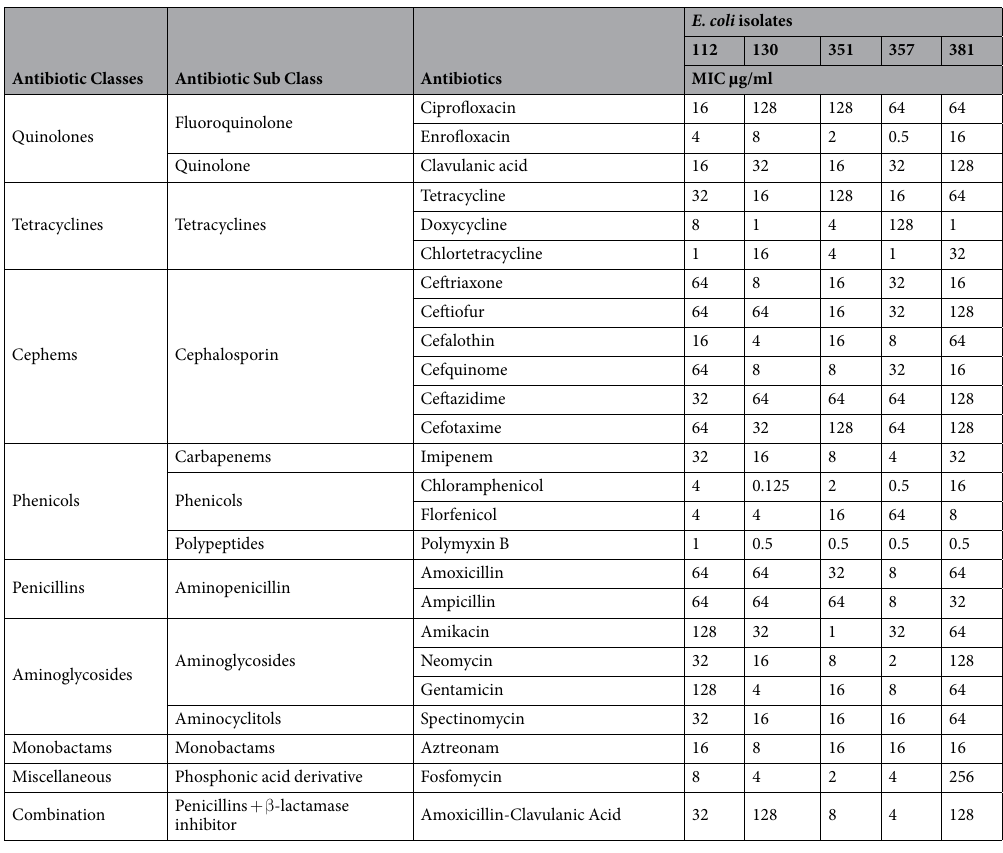
Table 1. MICs ( µ g/mL) of five MDR E. coli